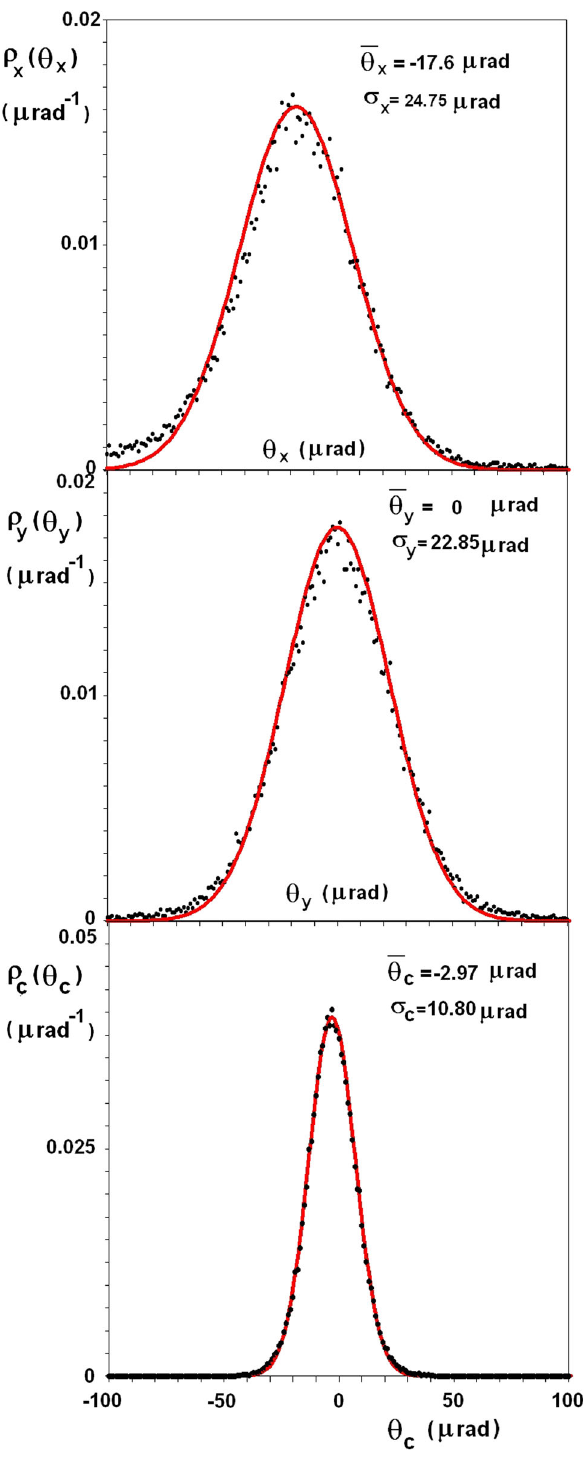
Fig. 4 The particle distributions (from Fig. 3) approximated by Gaus- sian functions